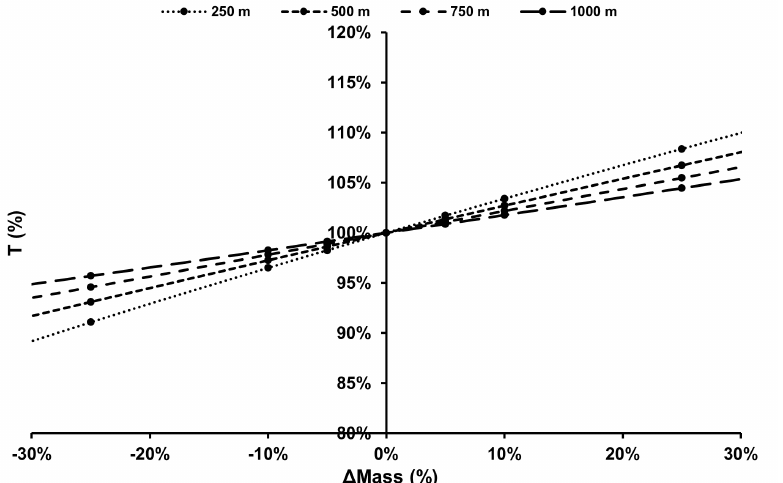
Figure 9. Change in the calculated run-time T of the generic athlete as a function of change in system mass m for distances from 250 to